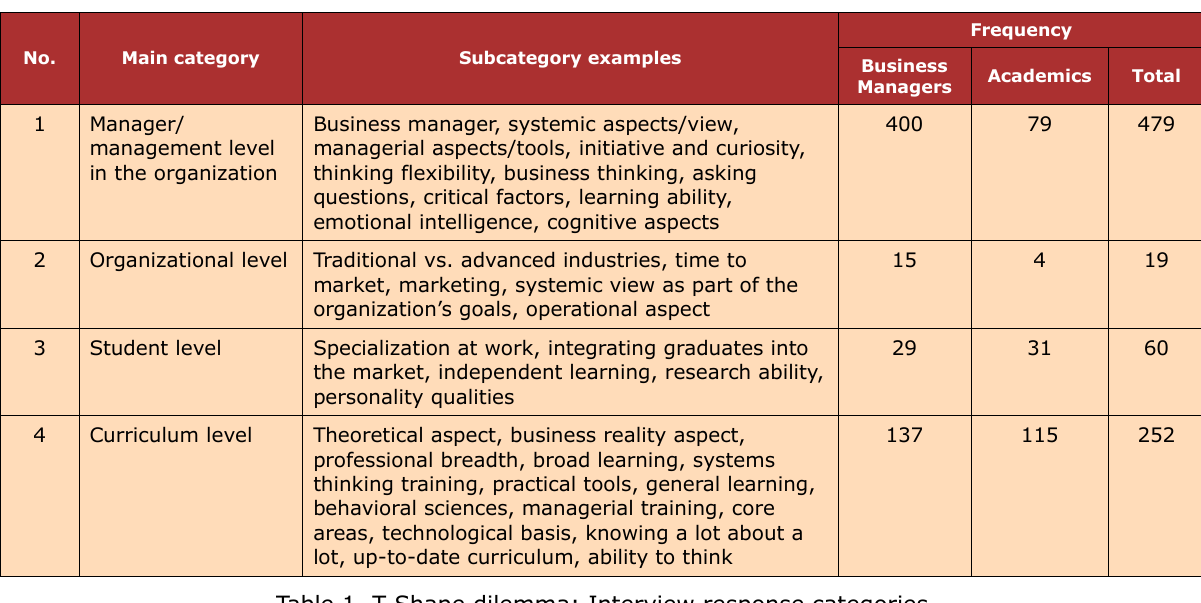
Table 1. T-Shape dilemma: Interview response